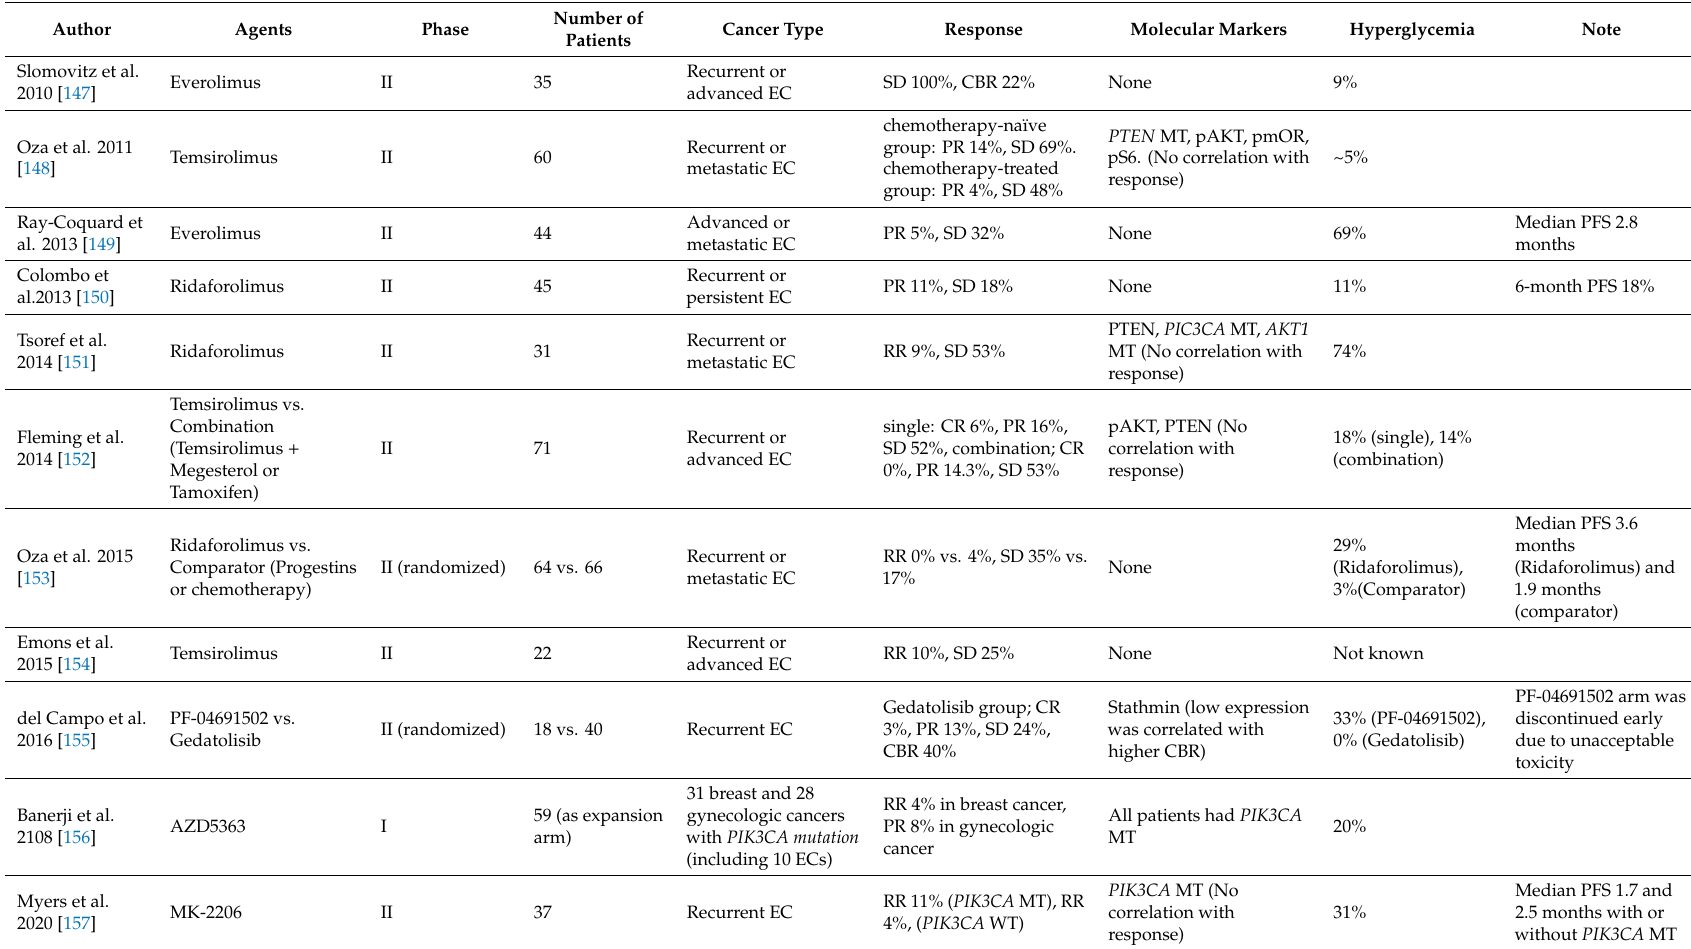
Table 2. Representative clinical trials for EC using PI3K-AKT inhibitors in the main